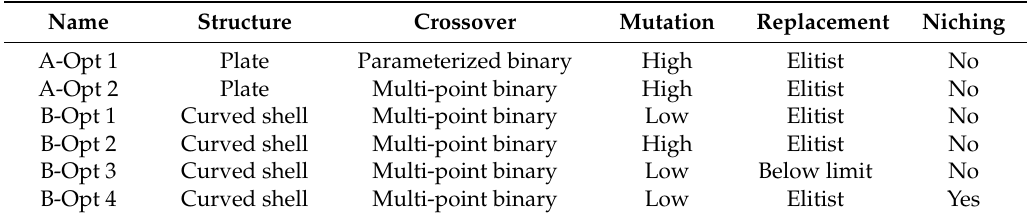
Table 1. Overview of the used optimization parameter (A = Optimization problem “plate”, B = optimization problem “curved